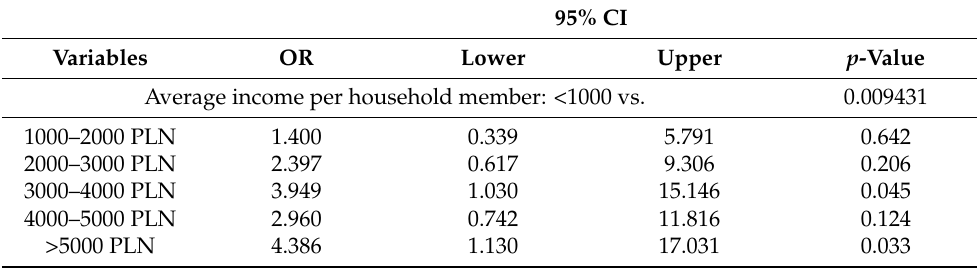
Table 4. Multivariate analysis regarding influenza vaccination